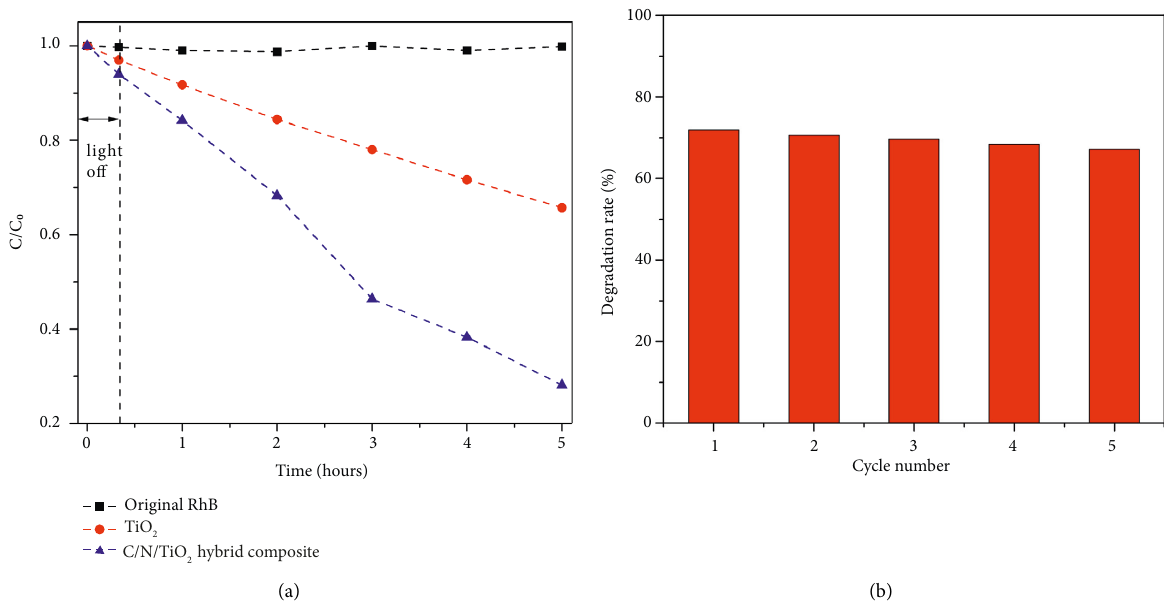
Figure 4: (a) Photocatalytic degradation of RhB in the absence of light (upto 20min) and the presence of pure TiO TiO 2 hybrid composite under visible-light irradiation. (b) 5 cycles of degradation of RhB using C/N/TiO 2 hybrid composite as the